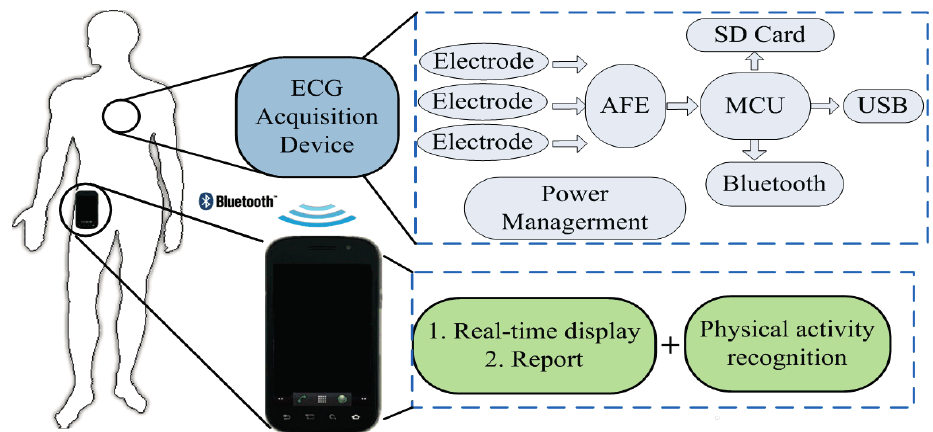
Figure 1. Schematic diagram of proposed context-aware electrocardiogram (ECG)